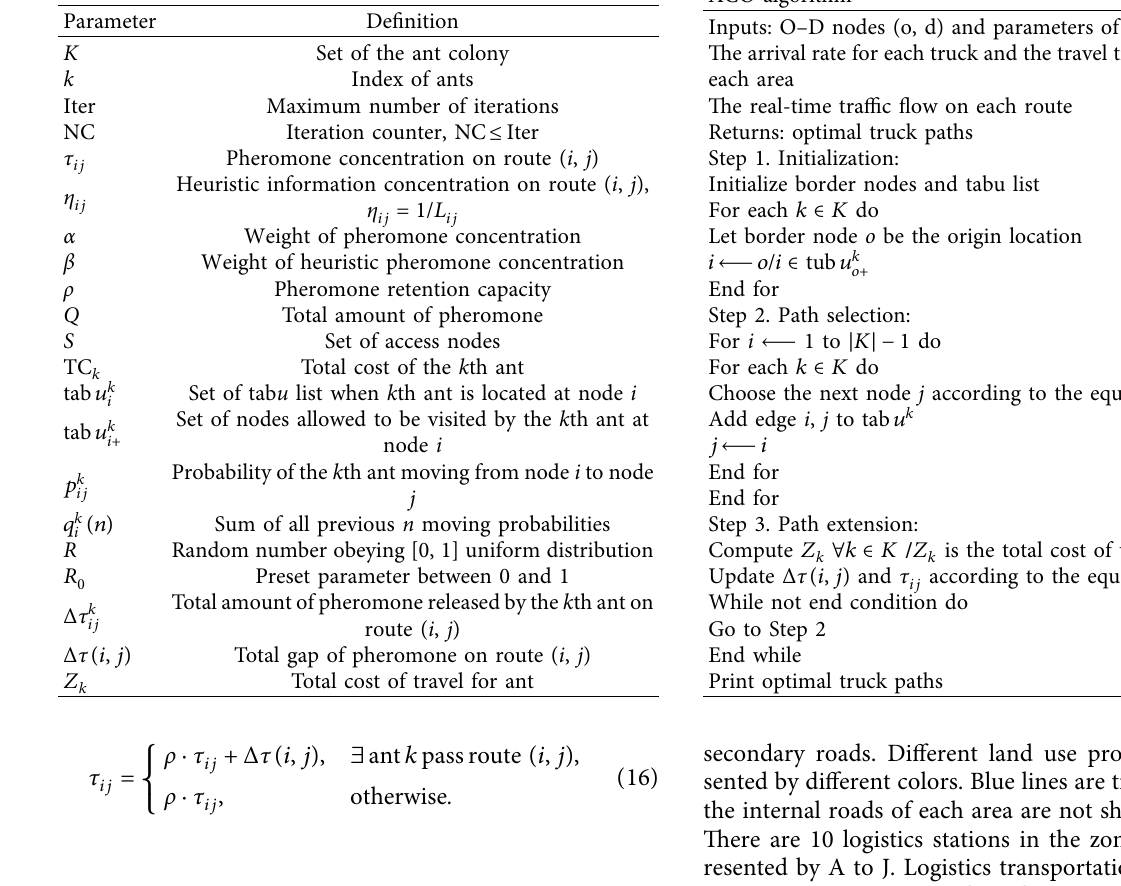
Table 3: The steps of ACO algorithms. ACO